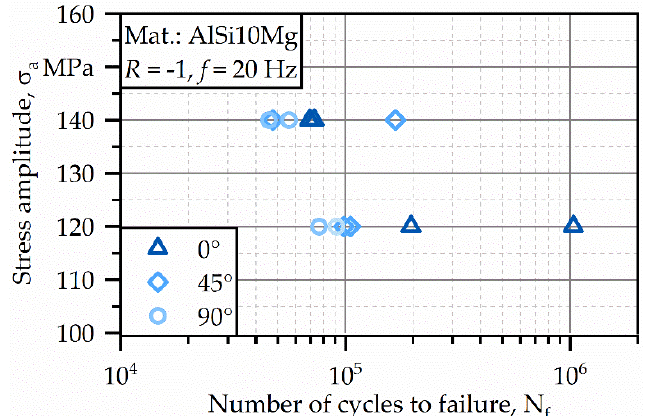
Figure 9. Results of constant amplitude tests for the AlSi10Mg building orientations 0°, 45°, and 90°.